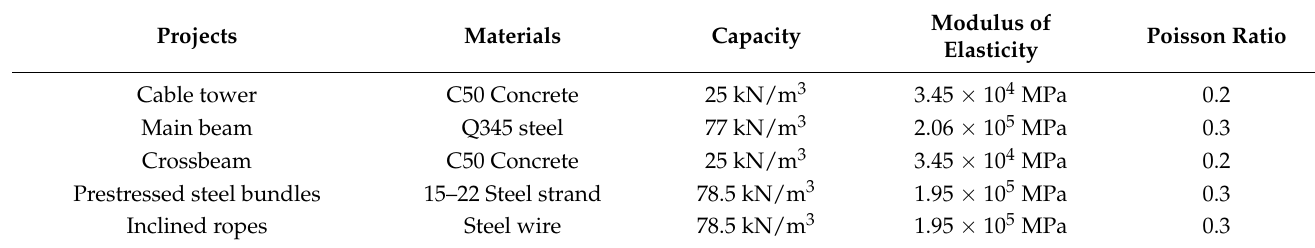
Table 3. The bridge sub-load table.